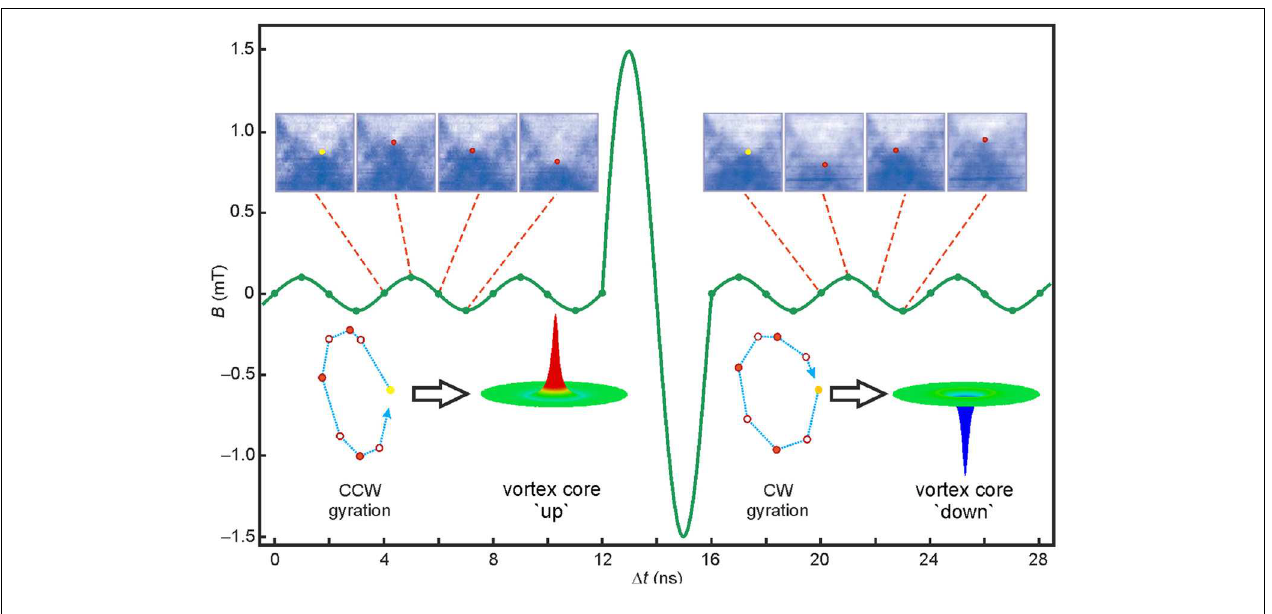
after the switching the vortex polarization p was probed by imaging the sense of rotation of the vortex gyration by time-resolved X-ray microscopy (CCW for vortex core “up,” CW for vortex core